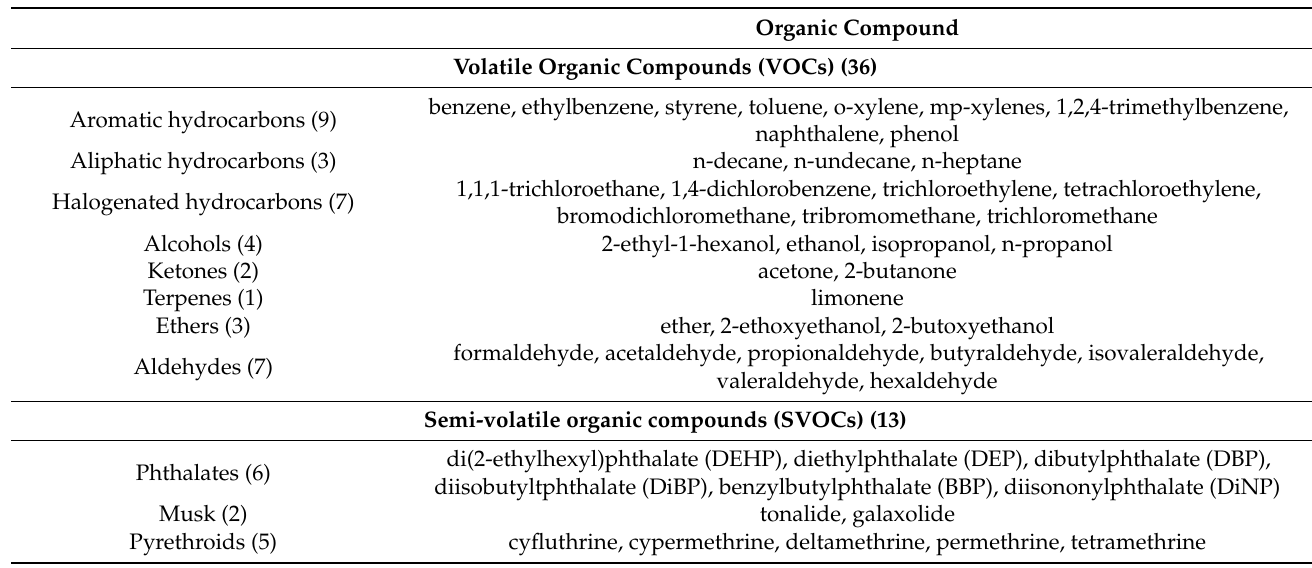
Table 1. Compounds of interest.